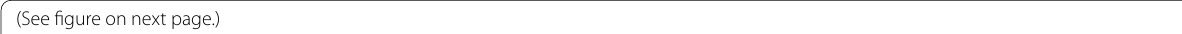
E)(See figure on next Fig. 10 Major lithologic features of the Allinges Mb. ( a , b ) and of the Vouan Conglomerate ( c – h ). a Massive sandstone accumulation at the large quarry of Allinges. b Erosive microconglomerate overlying a laminated coarse sandstone at the Rocher d’escalade exposure. c The Grande Gueule millstone quarry exposure. Letters refer to close‑up views depicted in next sub‑figures. d Remnants of millstone extraction from the Grande Gueule quarry. Note the homogeneous lithology of the excavated section. e The Grotte aux Loups exposure (46.3172° N, 6.4445° E) at the Maladière is the easternmost outcrop of the Vouan Conglomerate. f Pinch out and variable pebble size and distribution at the Grande Gueule quarry. Note the large block floating into the sandy matrix and the fining‑up grain‑size (black triangle). g Clast of black conglomerate of Paleozoic age characterising the Vouan Conglomerate from the Grande Gueule exposure. White circle: lens cap (72 mm). h Marly interval (sequence 3) of the Ruisseau de Curseille (46.2° N, 6.3712°